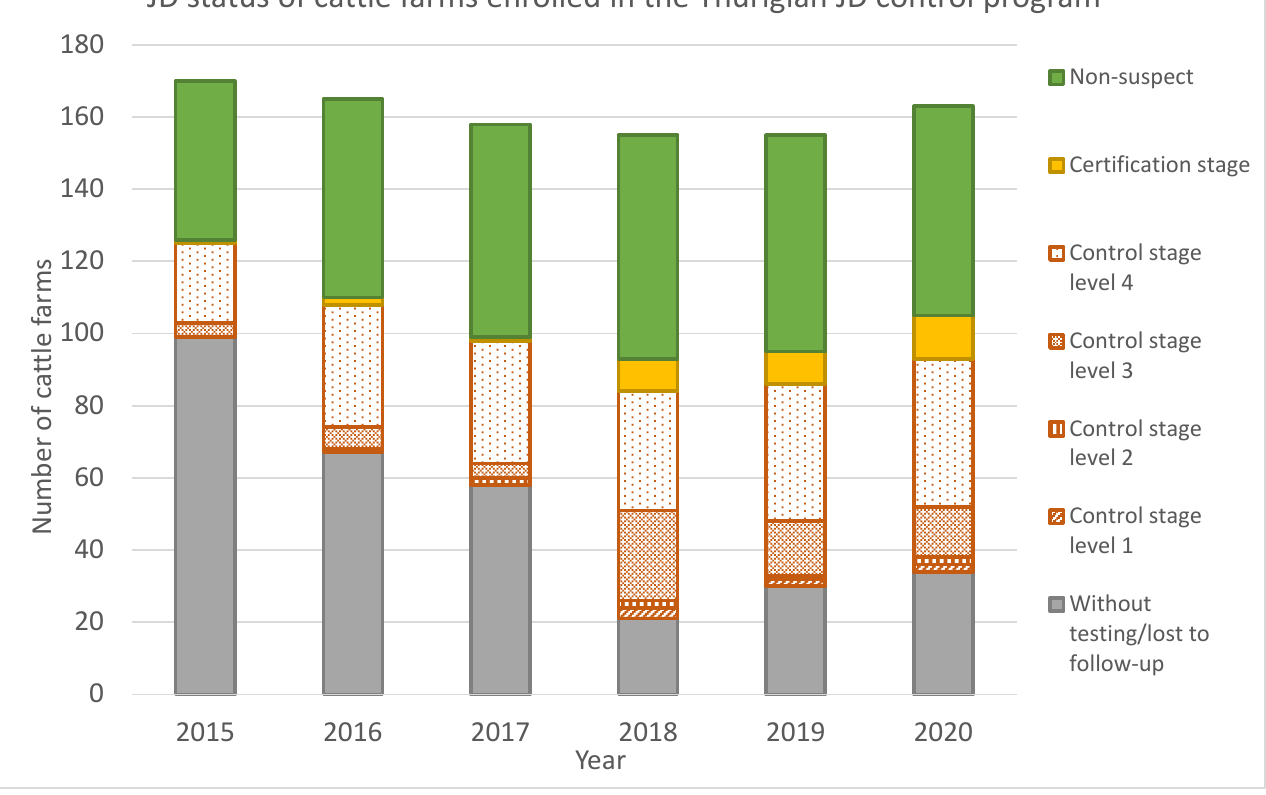
Figure 1. Number of cattle farms enrolled in the Thuringian Johne’s Disease control program with respect to the status achieved during the years 2015–2020.